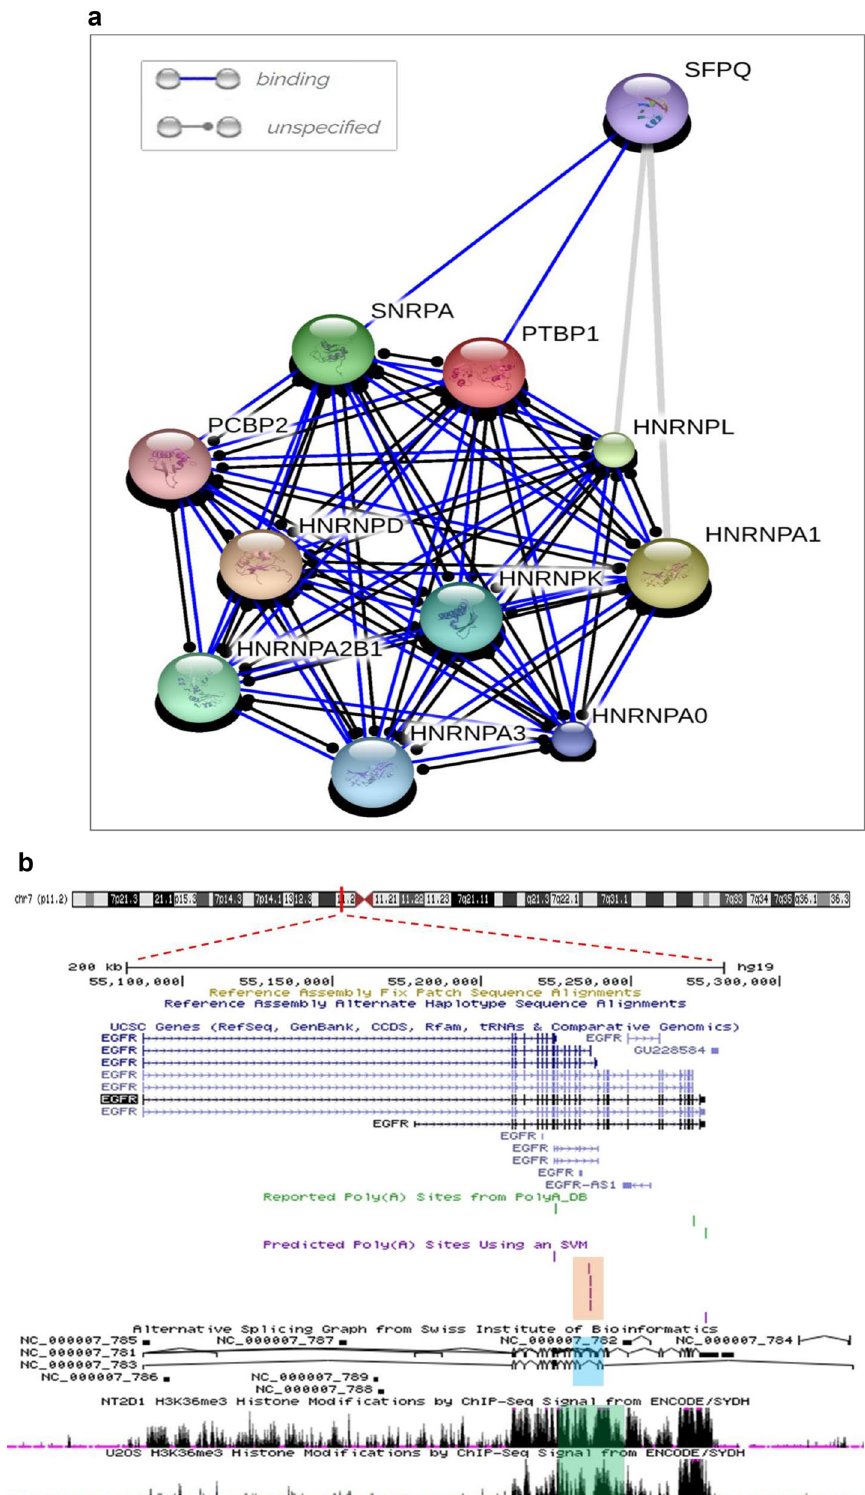
Figure 2. In-silico characterization of EGFR-AS1 role in alternative splicing of EGFR. ( a ) STITCH analysis showing the binding partners of PTBP1. ( b ) UCSC genome browser data shows the H3K36me3 marks (green box) and polyA sites (orange box) prevalence between exon 15 and 16 skipped region (blue box) of EGFR. ( c ) Relative expression level of PTBP1 in oral tumors compared with normal tissues. ( d ) Scatter plot showing the correlation analysis of EGFR-A and D isoforms expression in relation to PTBP1 expression. ( e ) Scatter plot showing the EGFR D/A ratio in relation to PTBP1 expression. (Statistical analysis was done by, two tailed Student’s t-test, Spearman rank correlation analysis, p-value * for <